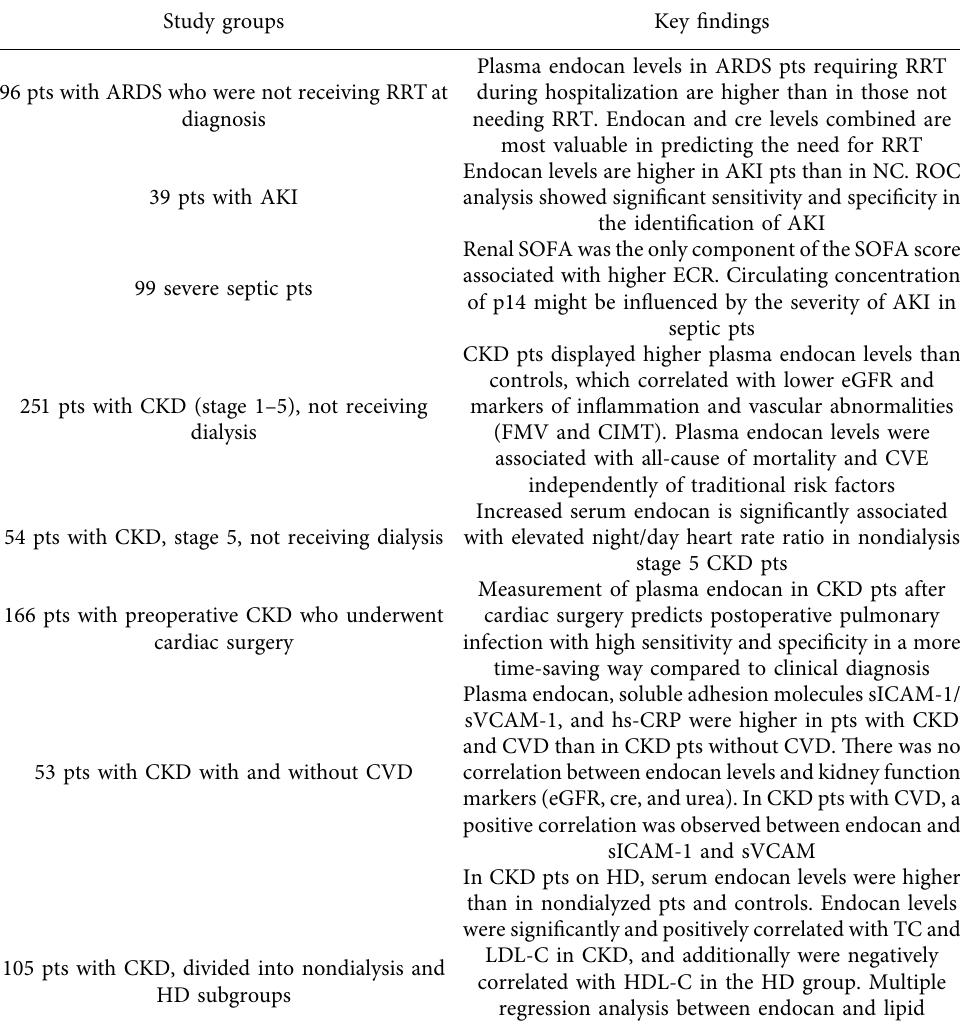
Table 2: The most important findings concerning the role of endocan in kidney